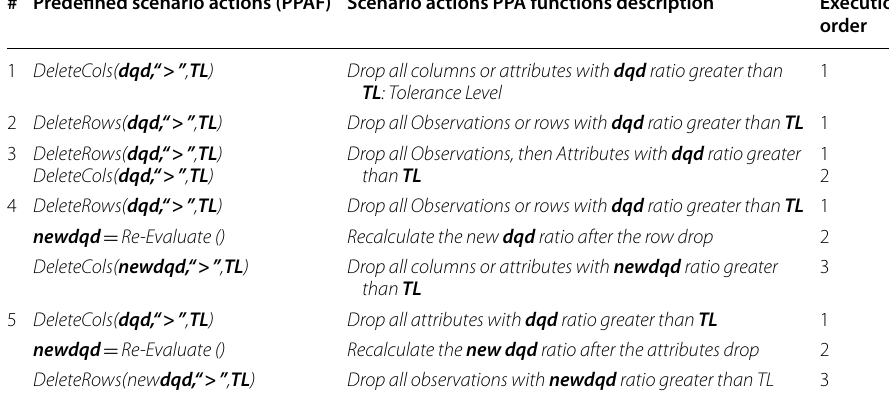
Table 7 Example of exploratory quality profiling scenarios # Predefined scenario actions (PPAF) Scenario actions PPA functions